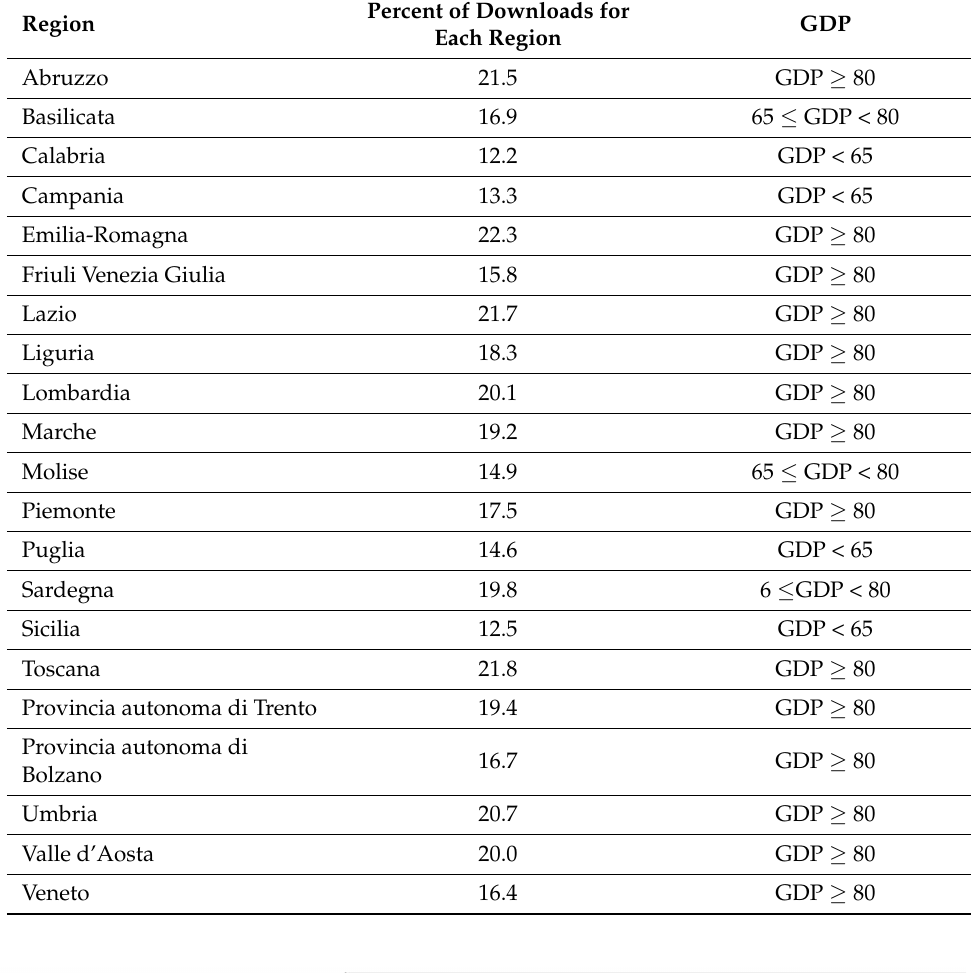
Table 2. Tabular representation of percent of downloads for each region and GDP. Region